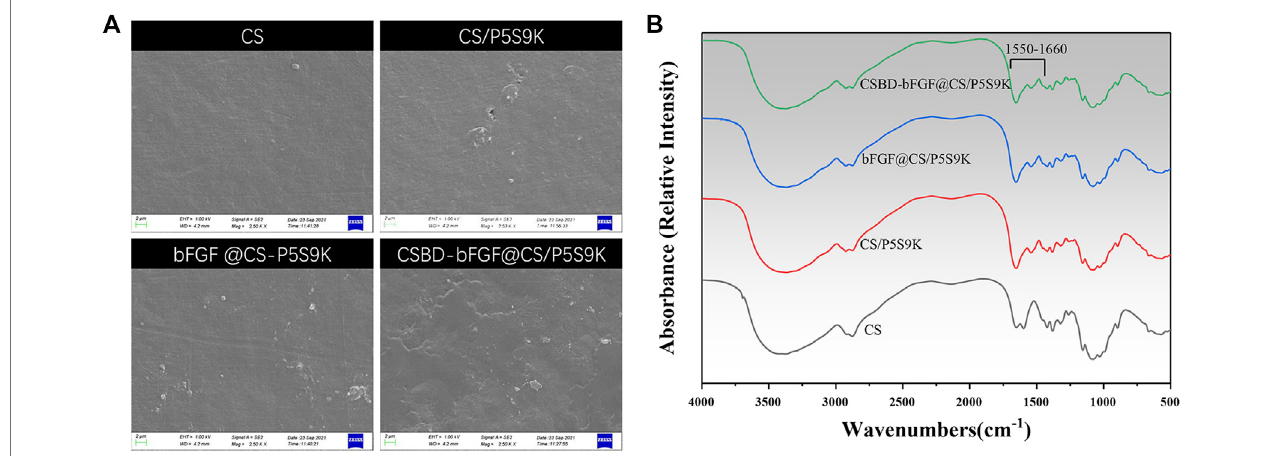
FIGURE 4 | (A) SEM images and (B) FTIR spectra of different membranes. The scale bars represent 2 μ m.